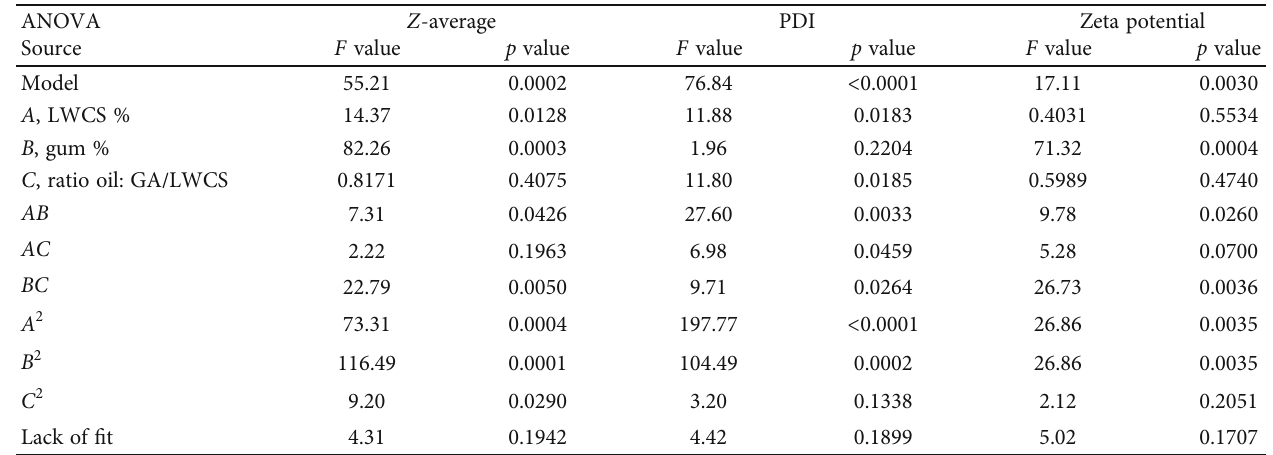
Table 4: ANOVA of Z -average, PDI, and zeta